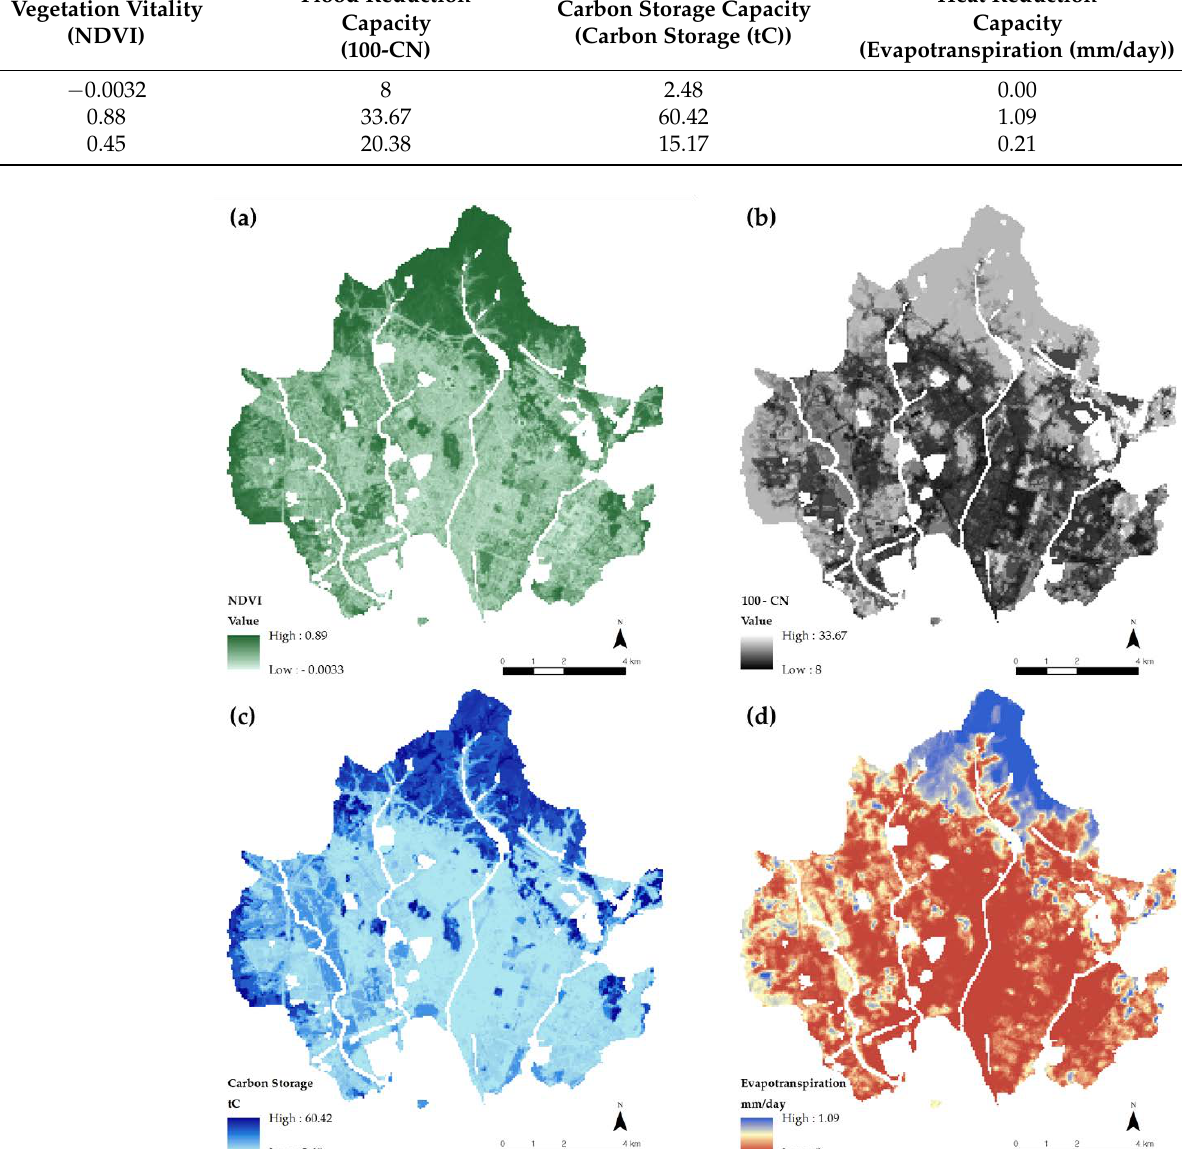
Figure 5. ERS maps ( a ) vegetation vitality: NDVI; ( b ) flood reduction capacity: 100-CN; ( c ) carbon storage capacity: carbon storage capacity; ( d ) heat reduction capacity: evapotranspiration.